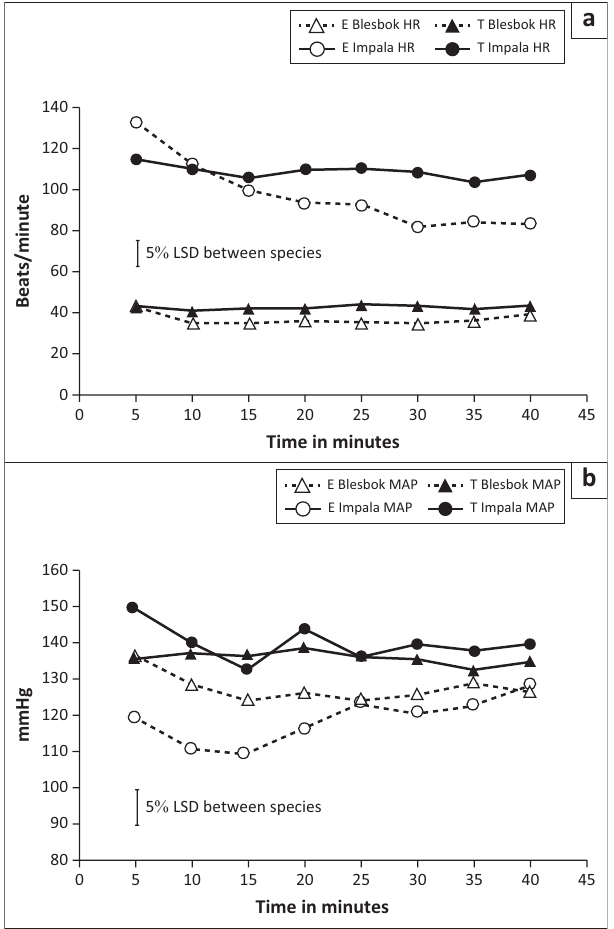
FIGURE 1: Heart rate (HR) in beats/minute (a) and mean arterial pressure (MAP) in mmHg (b) over time (minutes) of blesbok ( Damaliscus pygargus phillipsi ) and impala ( Aepyceros melampus ) immobilised with 0.09 mg/kg etorphine (E) or thiafentanil (T) respectively. Time was measured from when an animal became recumbent as a result of the immobilisation.